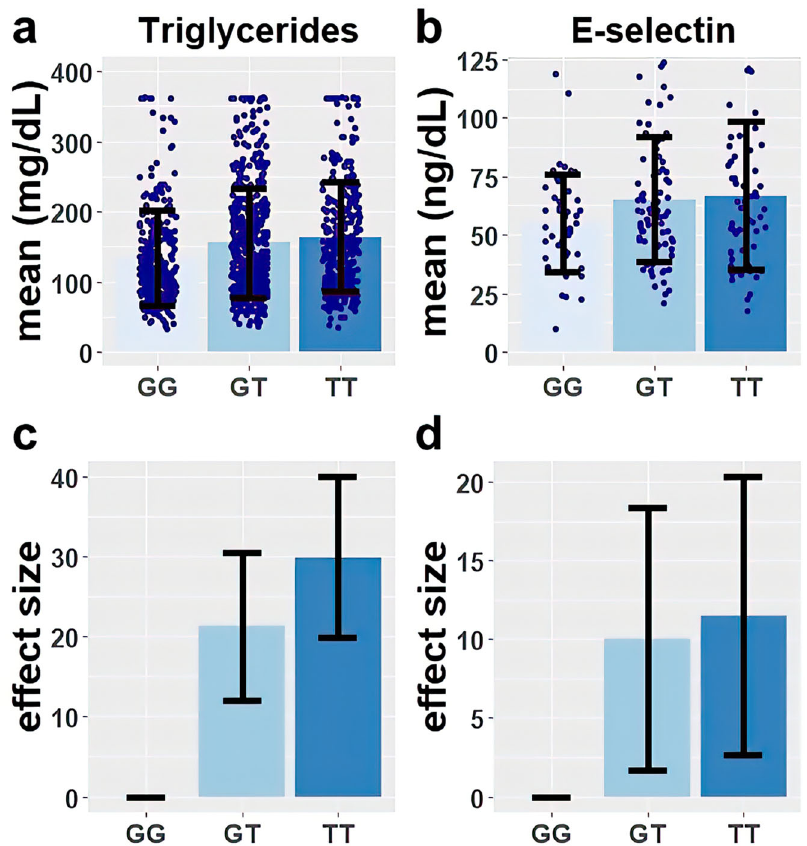
Fig. 3 Genotypic effects of rs174537 on triglycerides and E-selectin. The mean and standard deviation are shown for a triglycerides, and b E-selectin strati fi ed by rs174537 genotypes. The estimated effect and standard error among participants carrying one or two copies of the ancestral allele T (compared to the reference of zero), after covariate adjustment for age and sex are shown for c triglycerides, and d E-selectin. Numbers of independent samples for the analyses presented are 1101 (GG: 293;GT: 483;TT: 325) for triglycerides and 183 (GG: 48; GT: 76; TT: 59) for E-selectin. Source data for the fi gure are provided in Supplementary Data